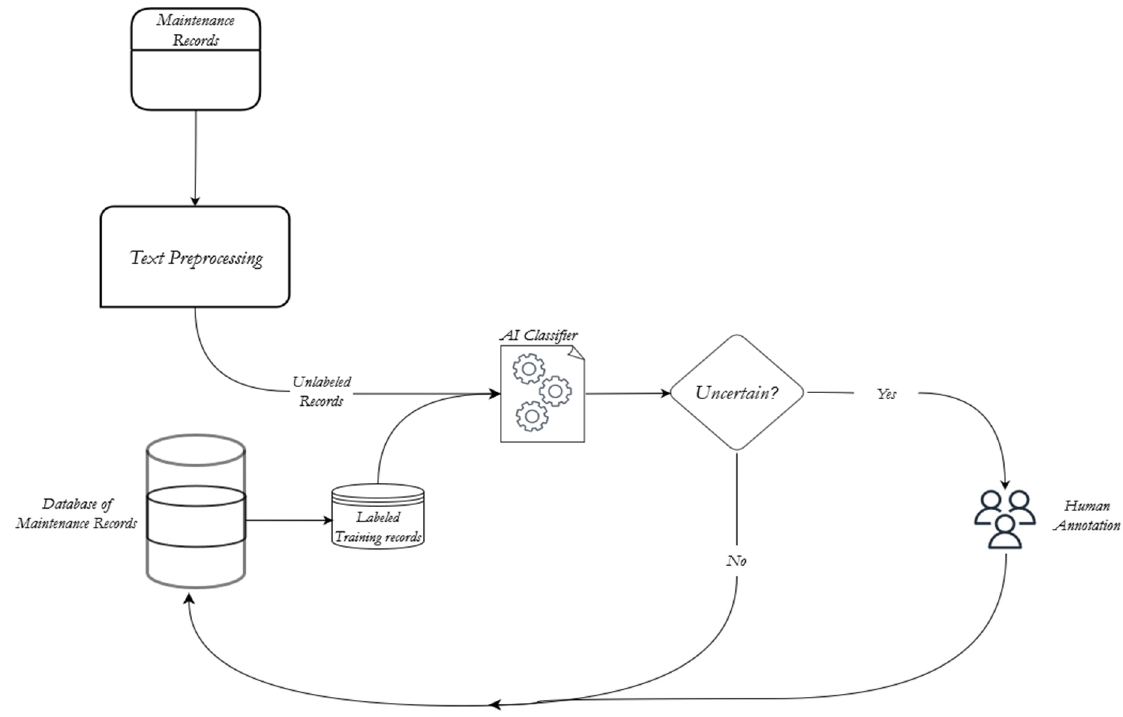
Figure 1. Research Framework.